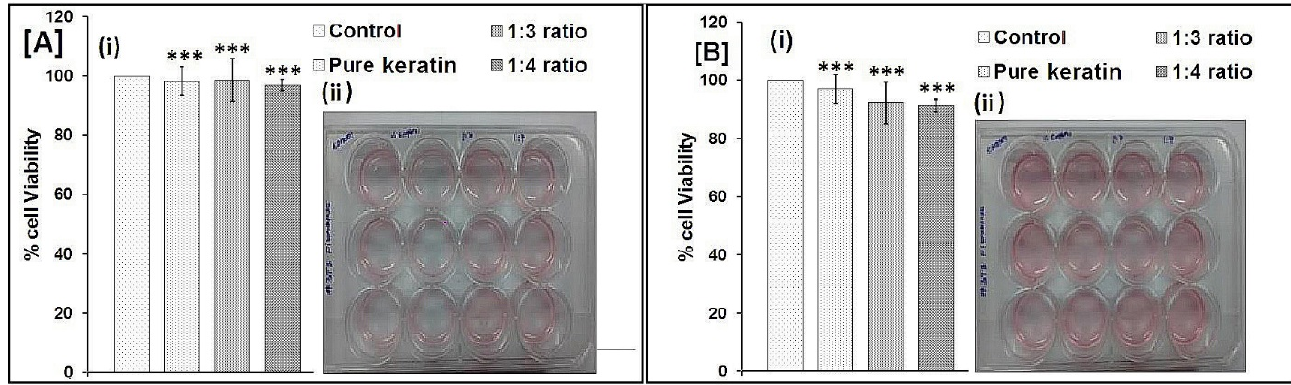
Figure 7. MTT assay of after ( A ) 24 h, and ( B ) 48 h (*** p < 0.05 calculated by the One-way ANOVA test).